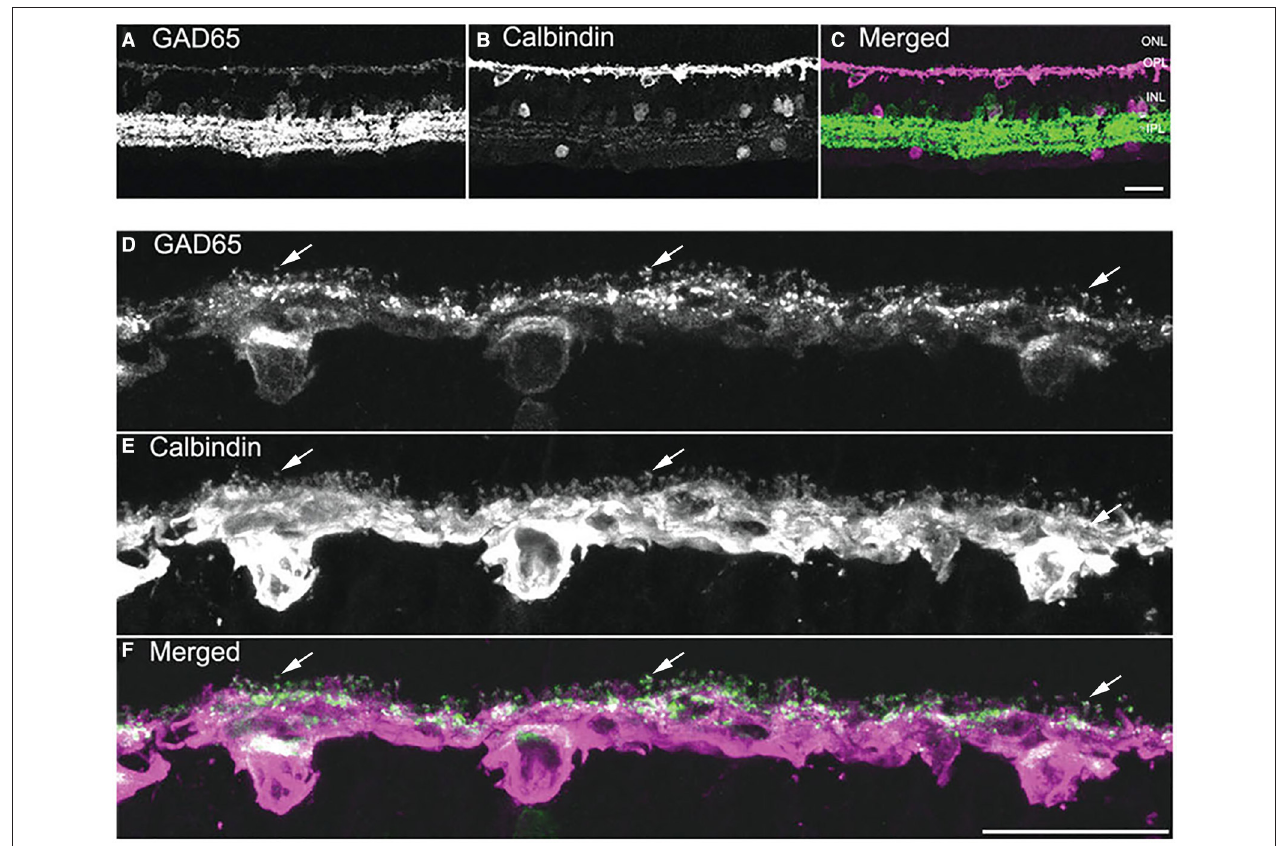
FIGURE 2 | GAD65 immunoreactivity is localized to horizontal cells. (A–C) A vertical section through the guinea pig retina was double labeled with antibodies to GAD65 (A) and calbindin (B) . In the outer retina, weak GAD65 immunostaining is present in the cell bodies and processes in the OPL; whereas, strong GAD65 immunoreactivity is in amacrine cell and displaced amacrine cell bodies and processes in the IPL. (B) Horizontal cell somata and processes are labeled with calbindin antibodies. (C) Merged image demonstrates GAD65 immunostaining co-localized with calbindin immunostaining in the outer retina. (D–F) Higher magnification views of the OPL showing the localization of GAD65 immunoreactivity in horizontal cell somata, processes, and endings. (D) GAD65 immunolabeling in the OPL. (E) Calbindin immunolabeling of horizontal cells. (F) Merged image shows the co-expression of GAD65 and calbindin immunoreactivities in the OPL, indicating that GAD65 immunoreactivity is localized to horizontal cell bodies, processes, and tips. Arrows in (D–F) point to GAD65 in horizontal cell endings. Images are maximum intensity projections of 6 optical sections, z = 5 µ m. Scale bar, 20 µ m in (C) (applies to A–C ), (F) (applies to D–F ). [Modified from ( Guo et al.,